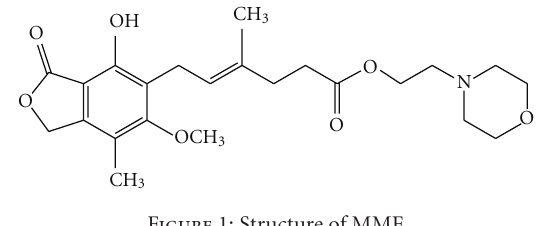
Figure 1: Structure of MMF.